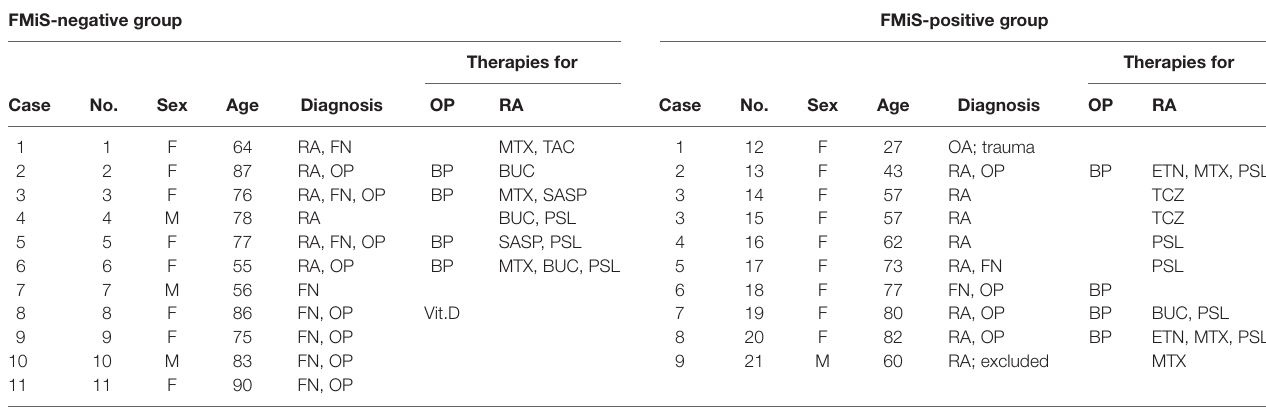
TaBle 1 | Characteristics of the patients. FMis-negative